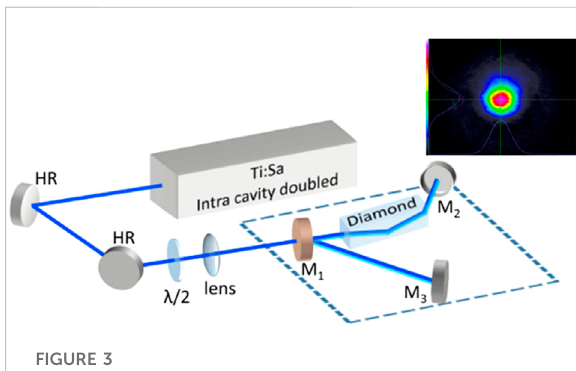
FIGURE 3 Schematic layout and beam spatial pro fi le of Ref. [46]. HR, high re fl ect mirror; Mx, mirror. Image originally published in Ref. [46] and reproduced with permission according to the